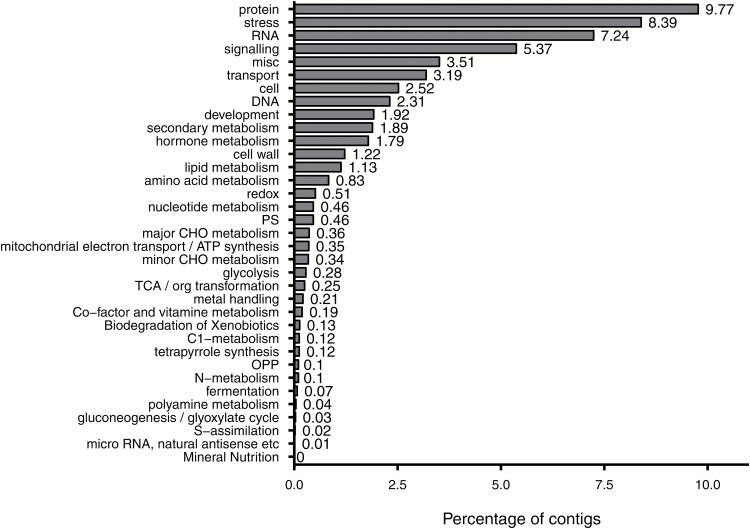
Classification of the de novo merged transcriptome into BIN code classes. The percentage of contigs annotated in each BIN code compared with the total number of annotations generated by Mercator is presented. Category number 35, ‘not assigned’, is not shown, and contained 44.7% of the assignments.